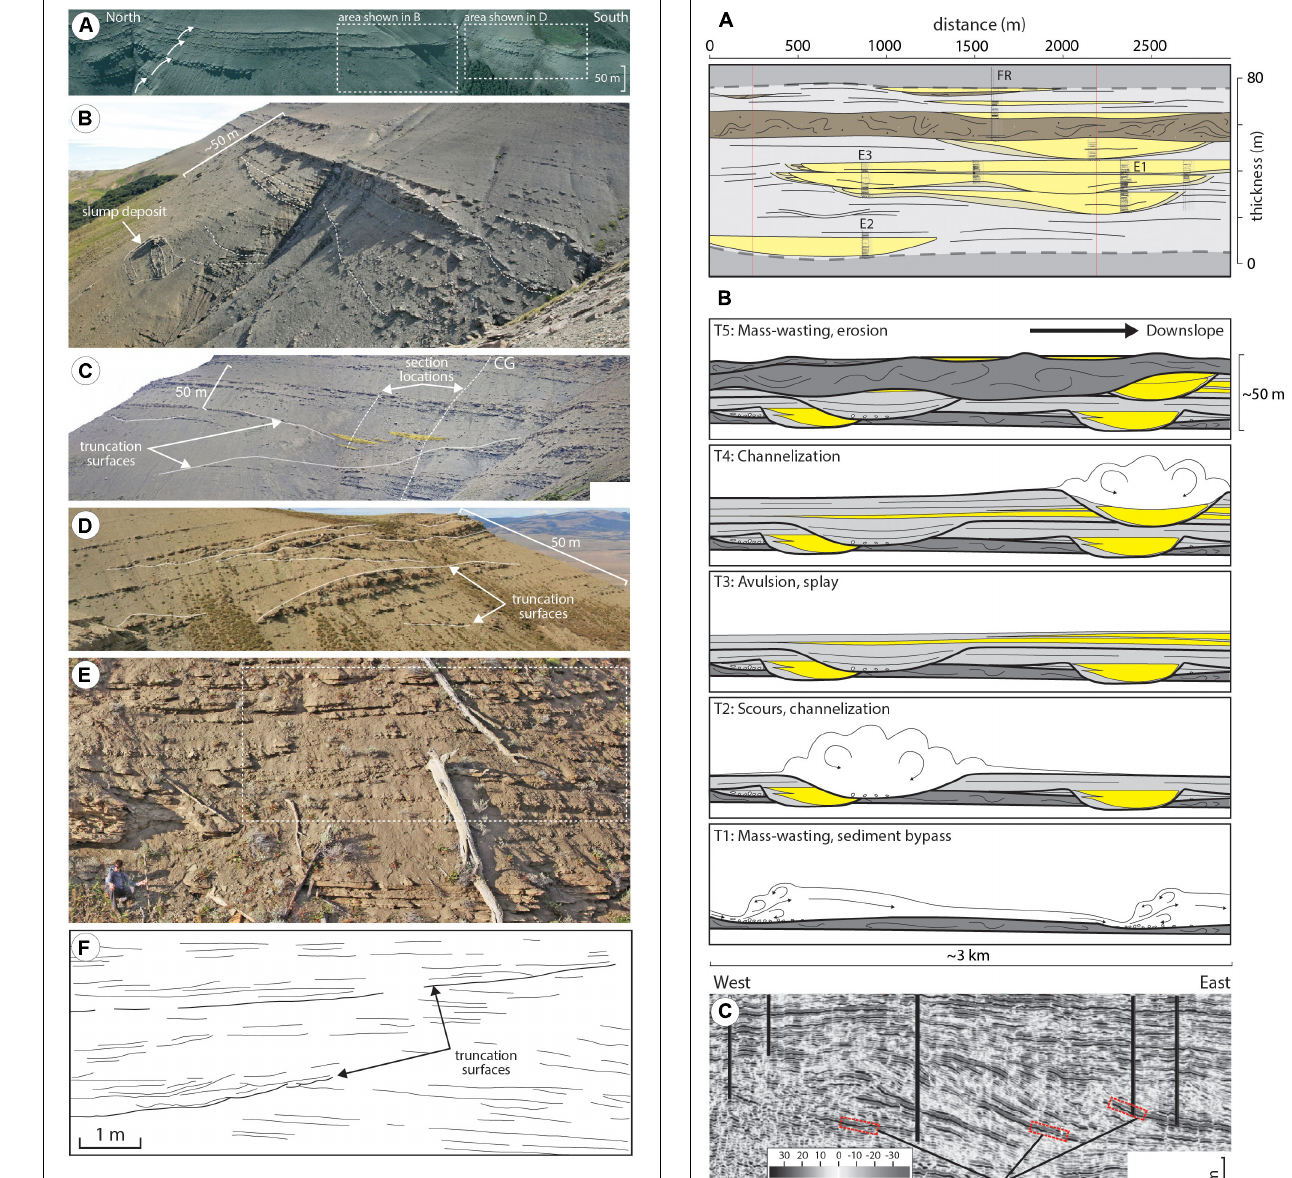
Frontiers in Earth Science |